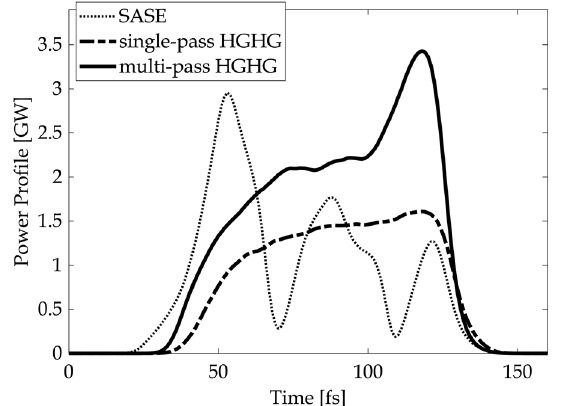
FIG. 9. Final output power profile for the three cases with the same input electron beam parameters. For the HGHG simula- tions, this is the 5th harmonic of 300 nm seed laser. For the multipass HGHG, we show the results for the 65th pass.